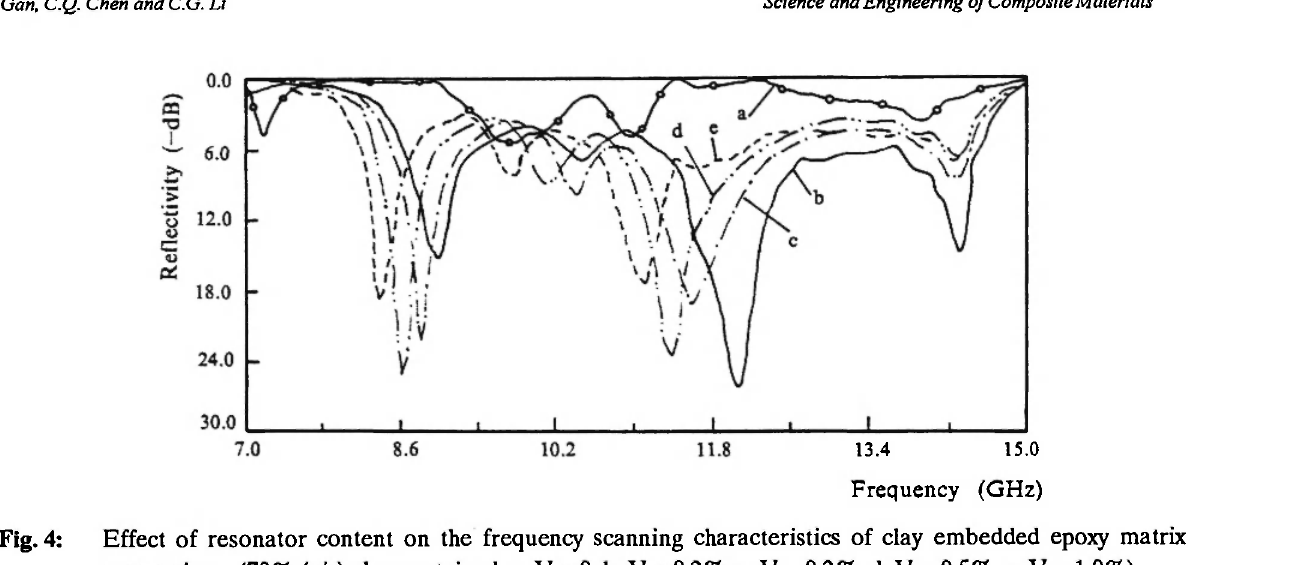
Effect of resonator content on the frequency scanning characteristics of clay embedded epoxy matrix composites. (70% (v/v) clay contained, a: V f =0, b: V f =0.2%, c: V f =0.3%, d: V f =0.5%, e: V f =1.0%).